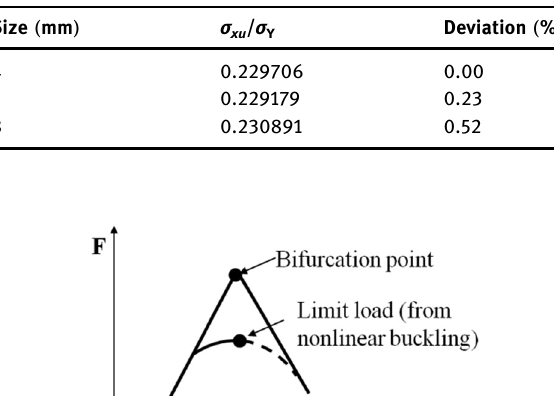
Table 1: Veri fi cation of mesh independence